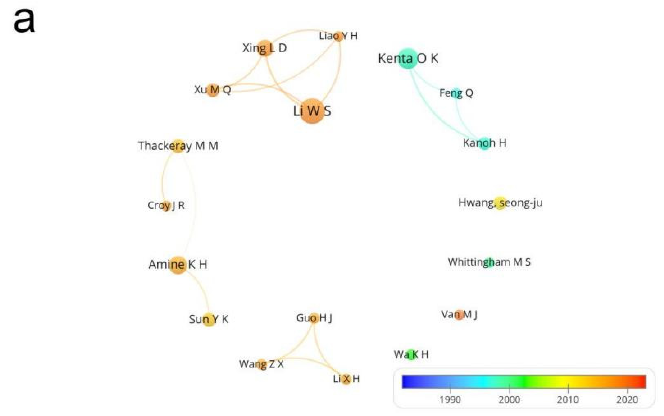
Figure 3. Contact between waste lithium-ion battery recycling issuing institutions: ( a ) institution clustering analysis (different colors, such as purple, light blue, and red, represent the different clusters they belong to, and different clusters are represented by different colors); and ( b ) institutions’ co-operation relationships.